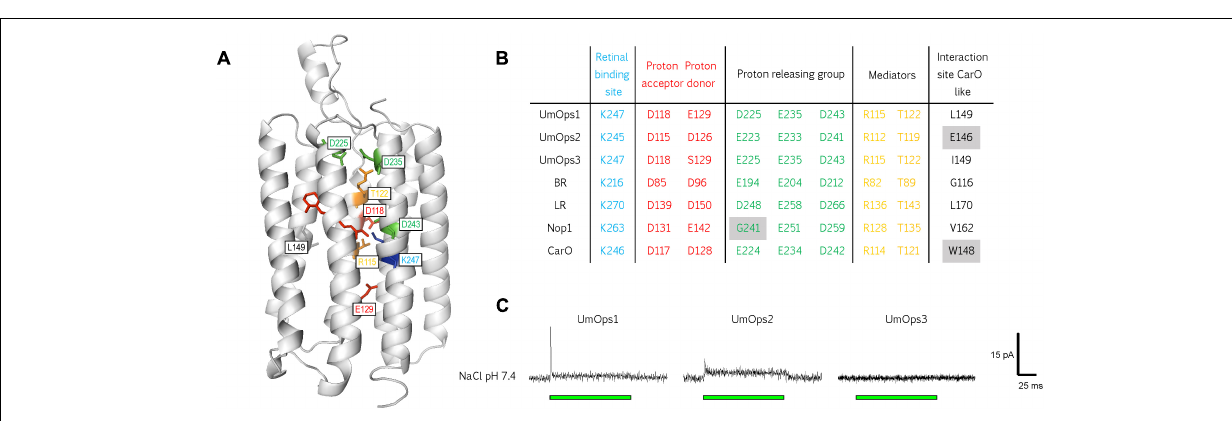
shown to influence the pumping behavior in BR and HR (Paula et al., 2001). This threonine residue is well conserved in the ascomycete rhodopsins with only a few exceptions (members of Chaetothyriales/Xylariales), where leucine or isoleucine is